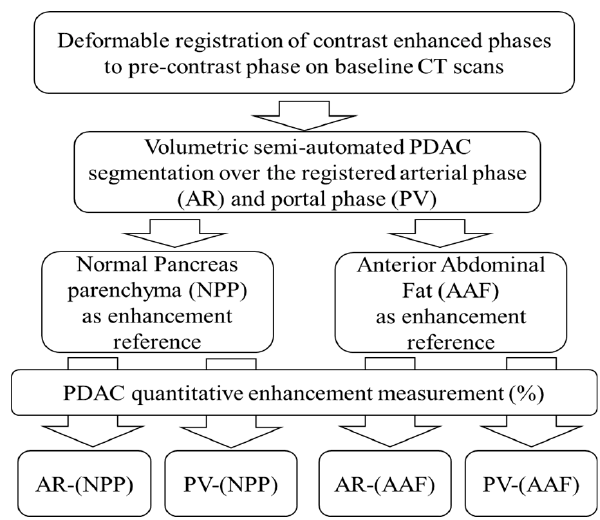
Figure 5. Image analysis pipeline yielded four different quantitative enhancement measurements.